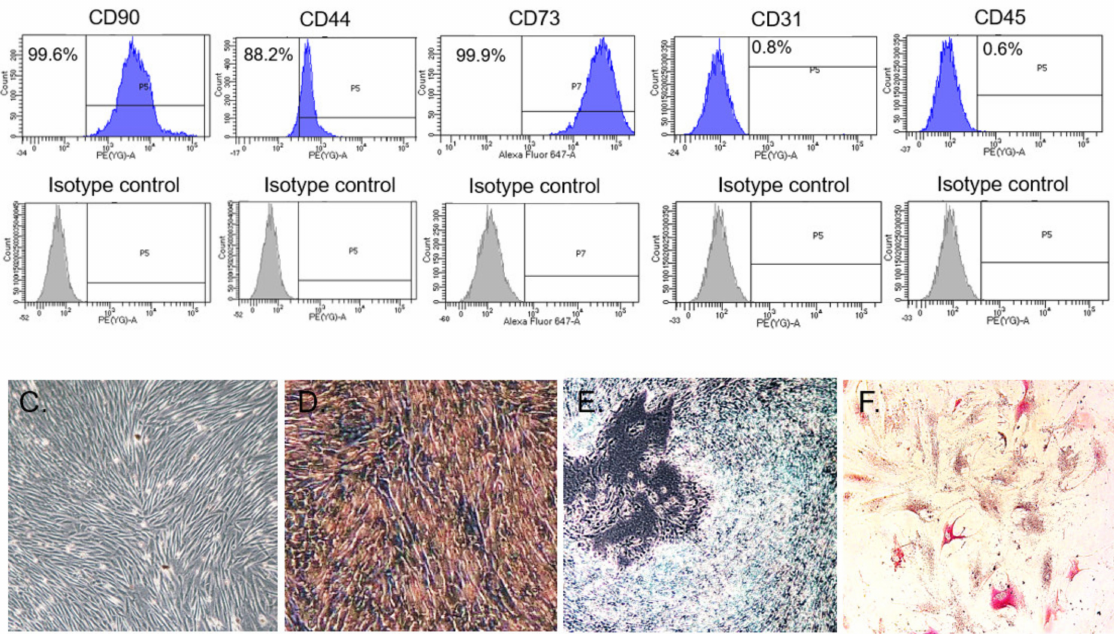
Figure 2. Surface marker expressions and differentiation potential of rabbit bone-marrow-derived stem/stromal cells (BMSCs). ( A ) BMSCs were separately incubated with each surface marker antibody at 4 ◦ C for 30 min and subjected to flow cytometry analysis. Histogram showing the intensity corresponding to the positive staining of each cell surface marker. ( B ) Histogram showing the intensity of the isotype control. The BMSCs displayed a phenotype profile of CD90 + CD44 + CD73 + CD31 − CD45 − . ( C ) Passage 2 adherent BMSCs cultivated in standard culture medium were found to exhibit a fibroblast-like morphology. ( D ) Alizarin red staining, ( E ) Alcian blue staining, and ( F ) Oil red O staining of BMSCs after osteogenic, chondrogenic, and adipogenic induction for 21 days,